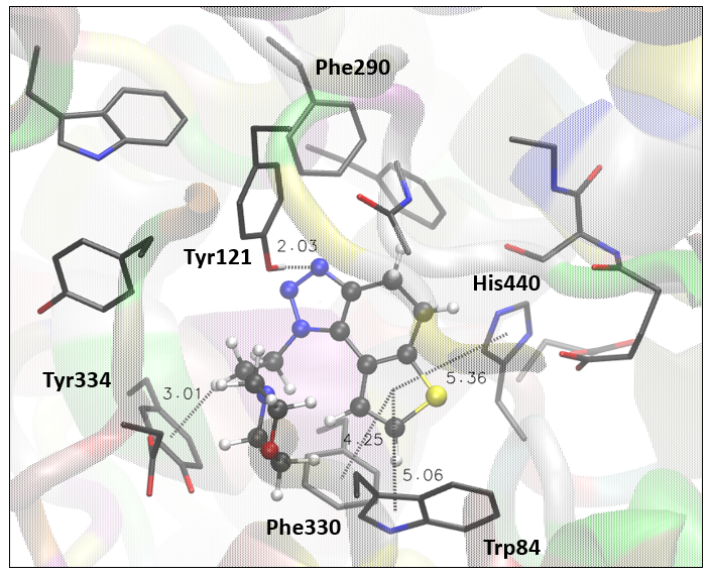
Figure 4. The structure of the complex between compound 17 (presented with a ball-and-stick model) and the active site of AChE. Hydrogens of the enzyme residues are omitted for clarity. The π -alkyl a tt raction is observed between the ethyl chain at triazole and Tyr334,